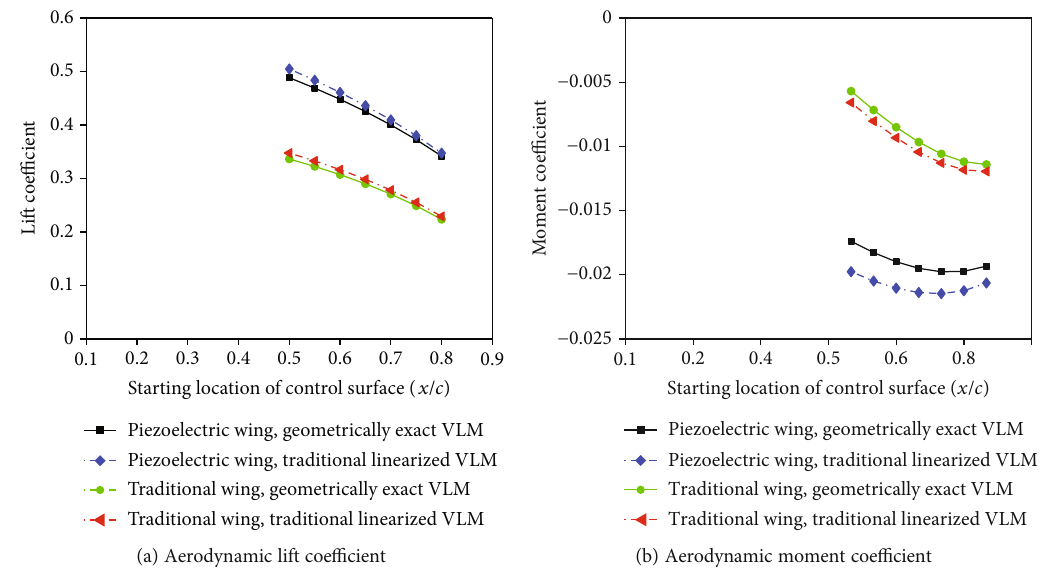
Figure 5: E ff ects of control surface length on aerodynamic coe ffi cient.